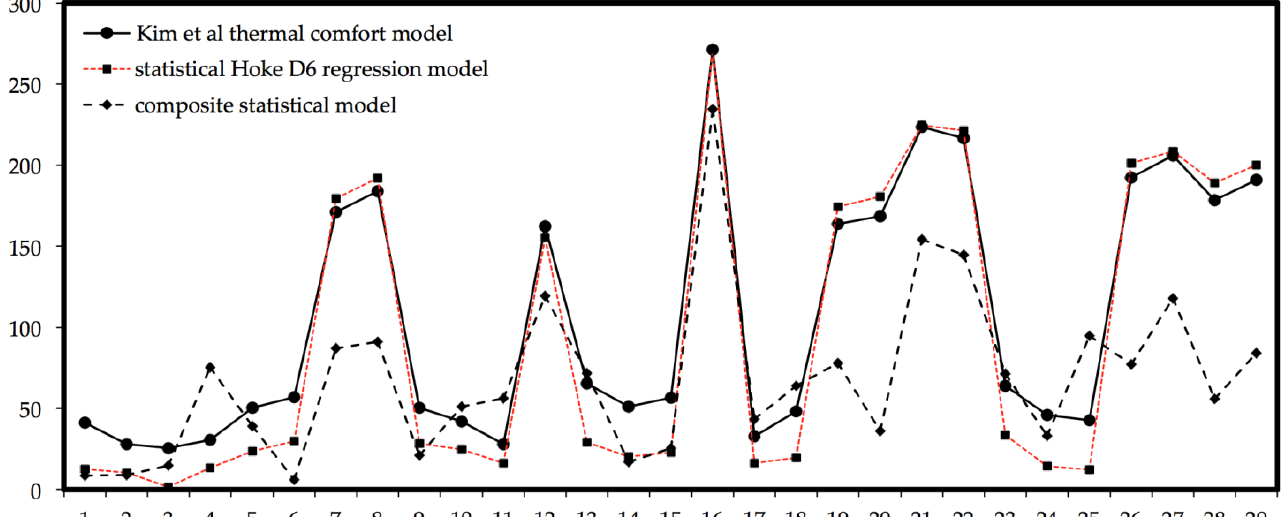
Figure 3. Test dataset comparison. Hoke D6 design model’s satisfactory fit to Kim et al.’s model